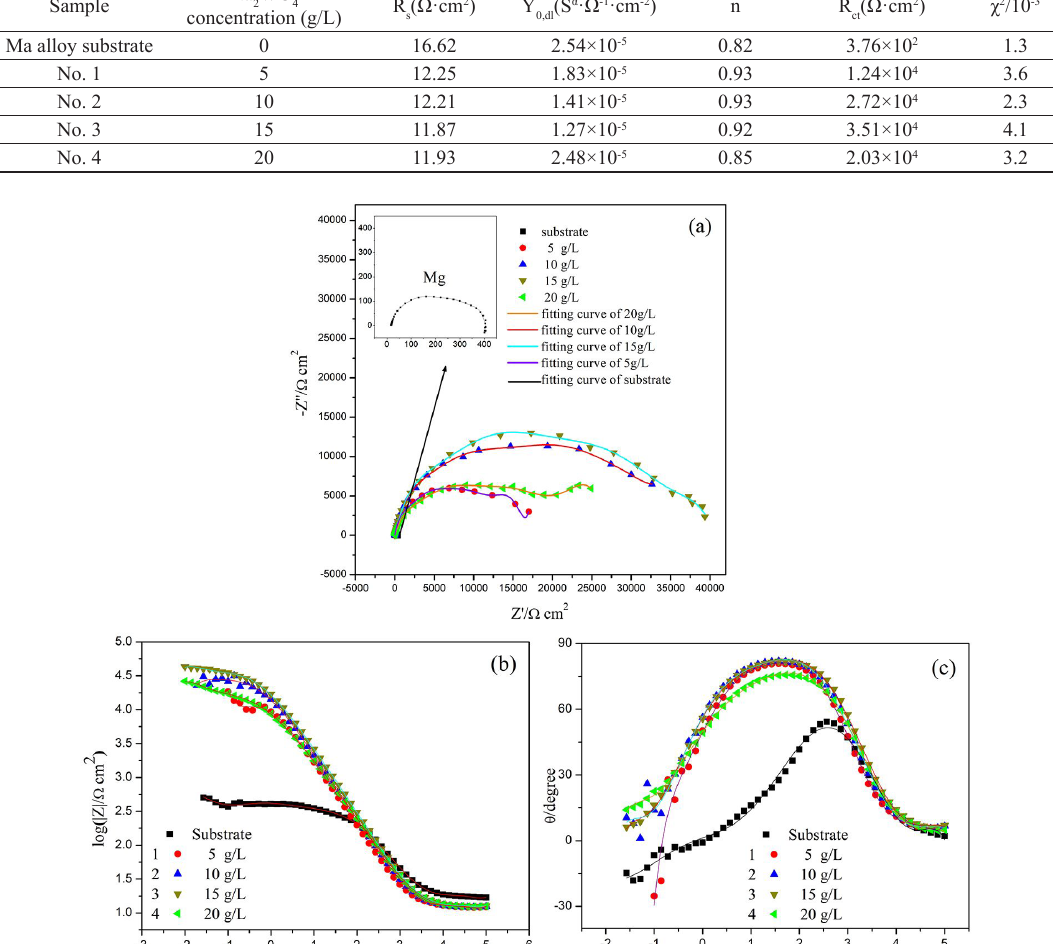
WO concentrations in 2 4